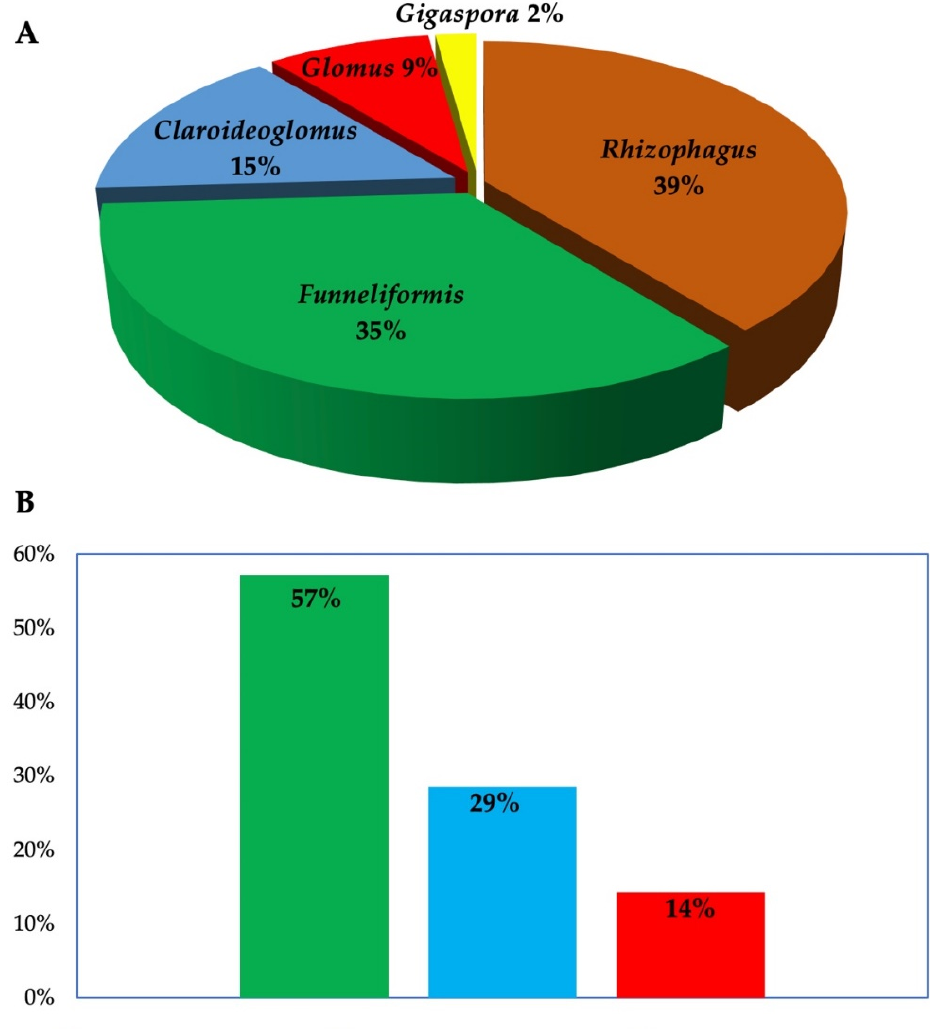
Figure 1. ( A ) AMF genera whose ecological effects were investigated in the field ( B ) Time-dependent changes in the abundance of introduced AMF according to results from six sites where the abundance of introduced AMF was monitored using metabarcoding twice or more. Introduced AMF: decreased in abundance compared to previous sampling; excluded (not detected in the sample) or abundance remained the same.